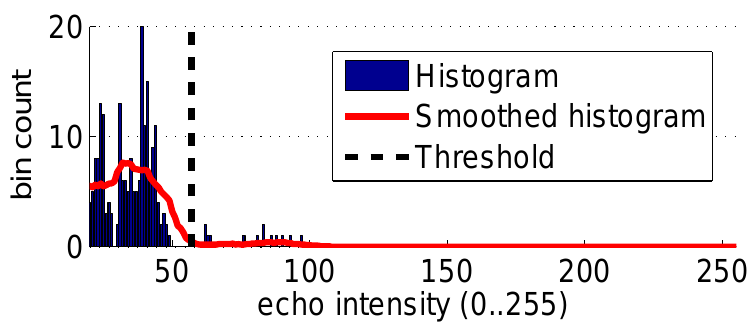
Figure 8. An example of the threshold selection